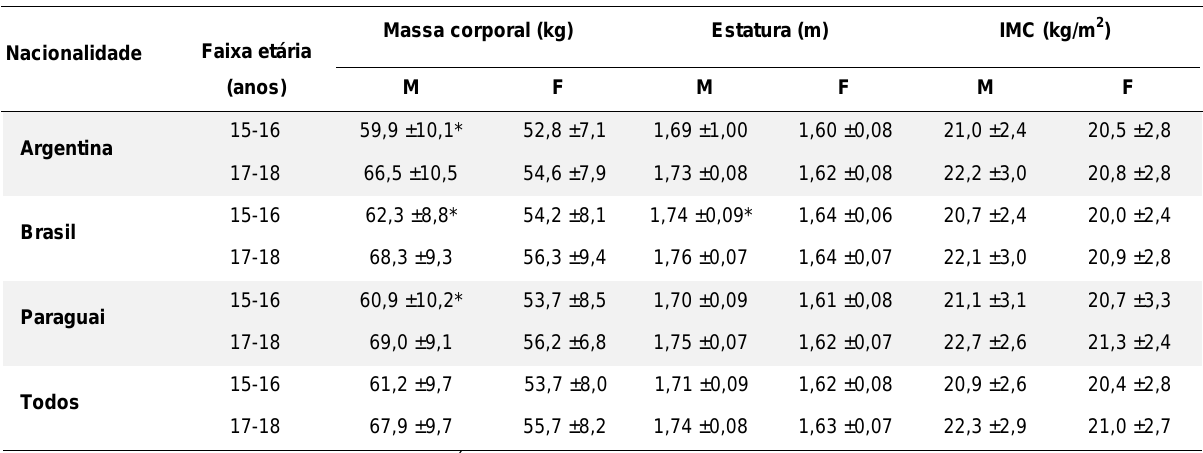
Tabela 2. Características antropométricas autorrelatadas pelos adolescentes da Tríplice Fronteira,